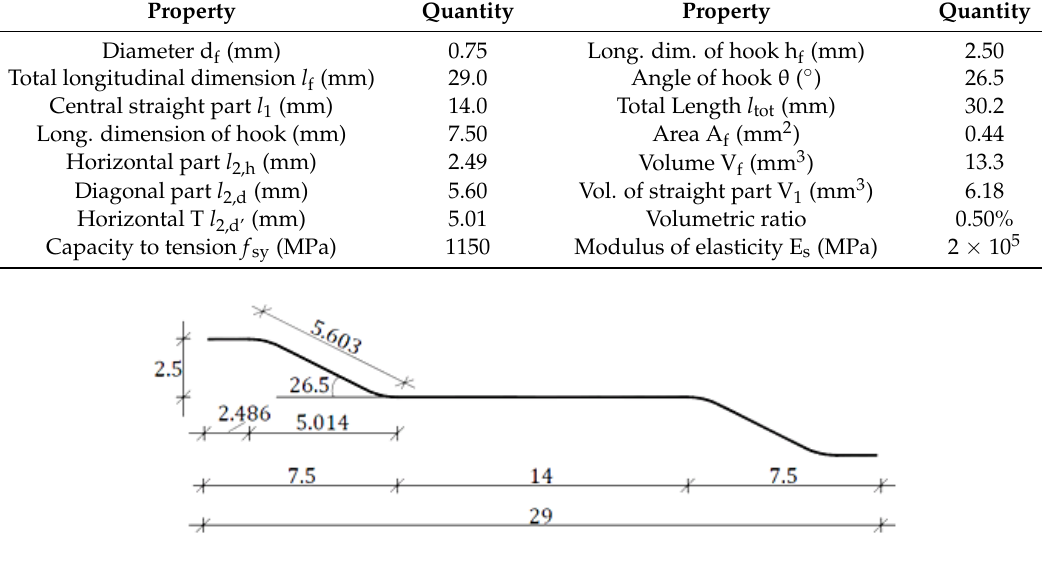
Figure A1. Geometry of the fibers of the case study (dimensions in mm). Table A2. Characteristics of the concrete specimen.